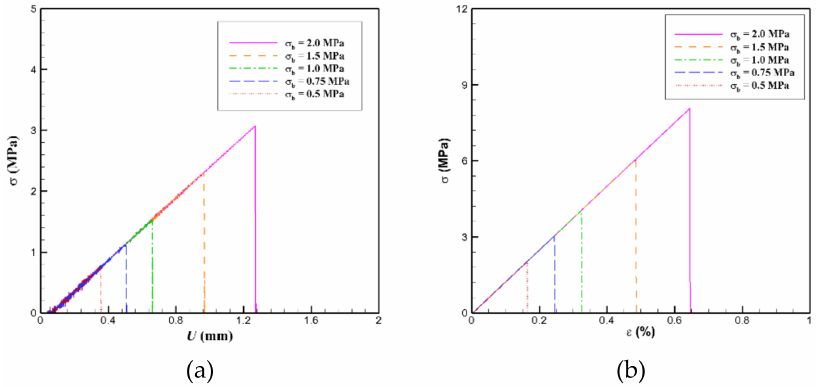
Figure 7. Effect of bond strength on: ( a ) stress–deflection curve; ( b ) stress–strain curve.